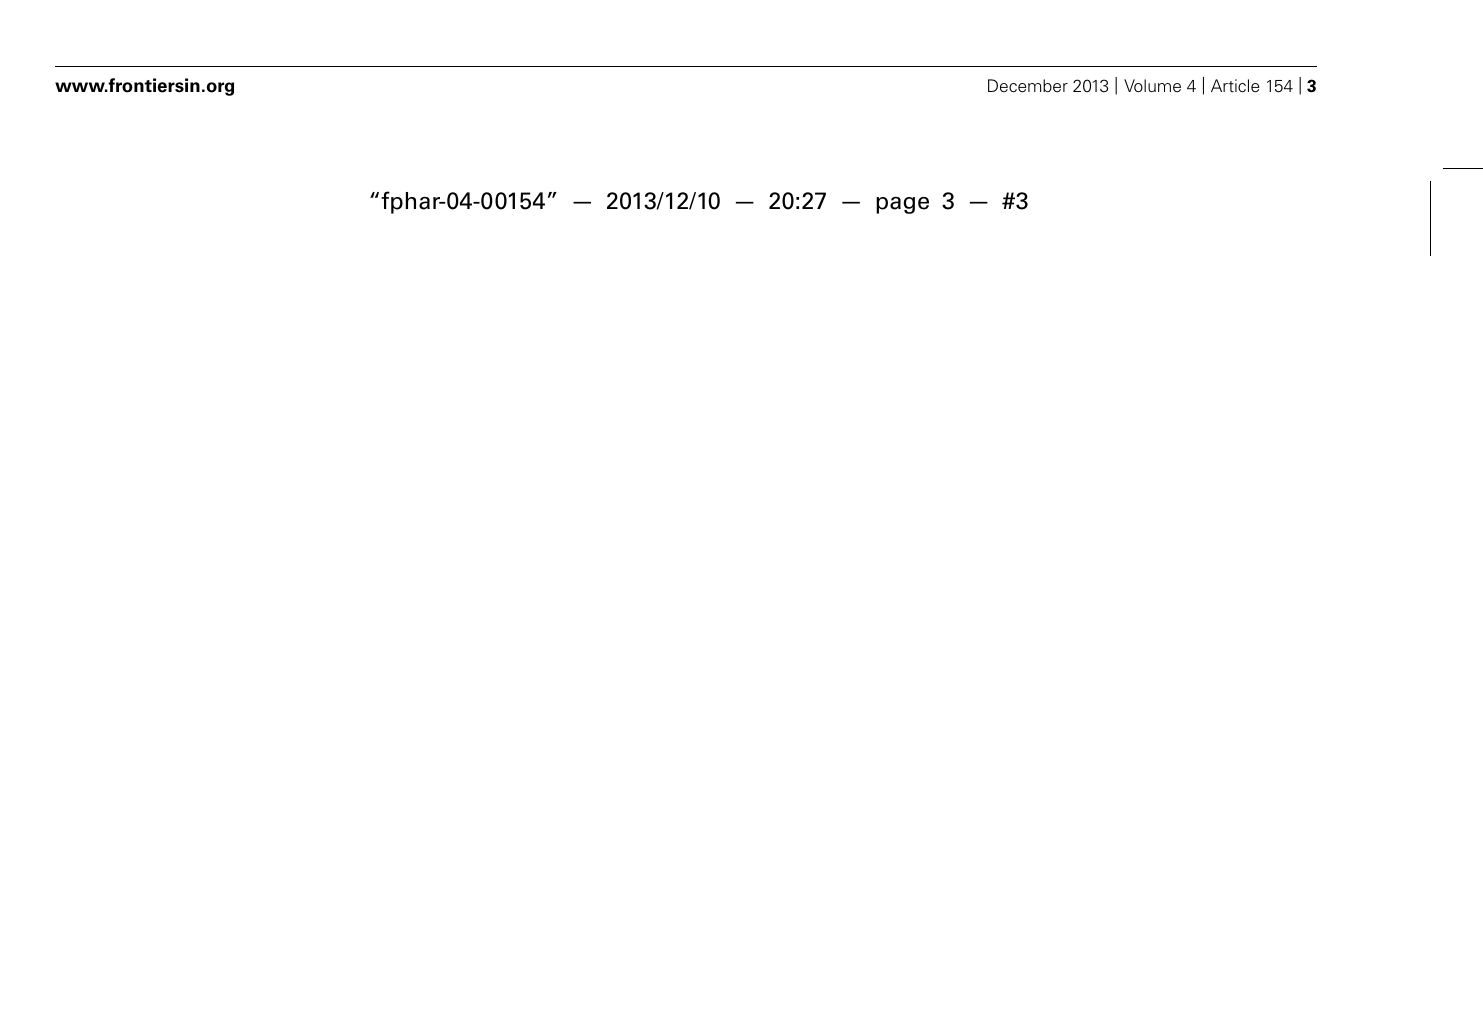
FIGURE 1 | The essential amino acid tryptophan is required for protein biosynthesis or is metabolized via two biochemical routes: (i) via tryptophan 5-hydroxylase (T5H) and subsequent decarboxylation to